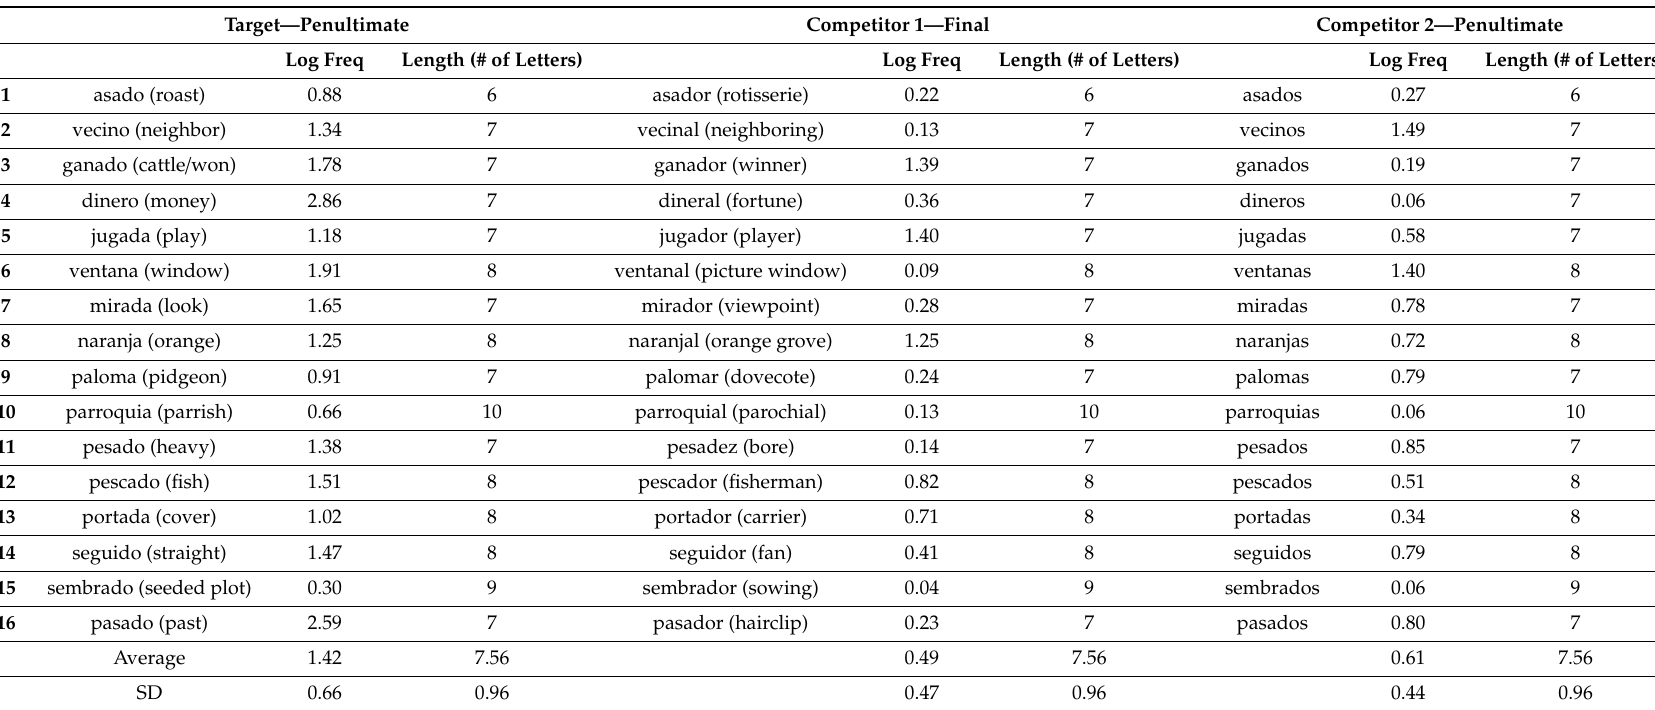
Table A4. Information regarding the experimental trials in this experiment. Non-cognate condition. The log frequency of the target and competitor words was obtained using the subtitle token corpus in EsPal (Duchon et al. 2013), provided by the Basque Center on Cognition, Brain, and